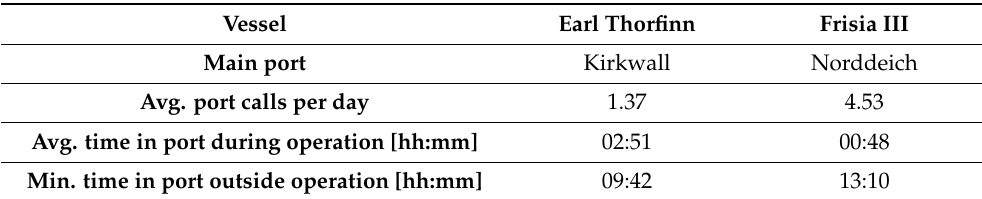
Table 3. Port call times of the two case study vessels, Earl Thorfinn and Frisia III, shown including breaks during operation and overnight.